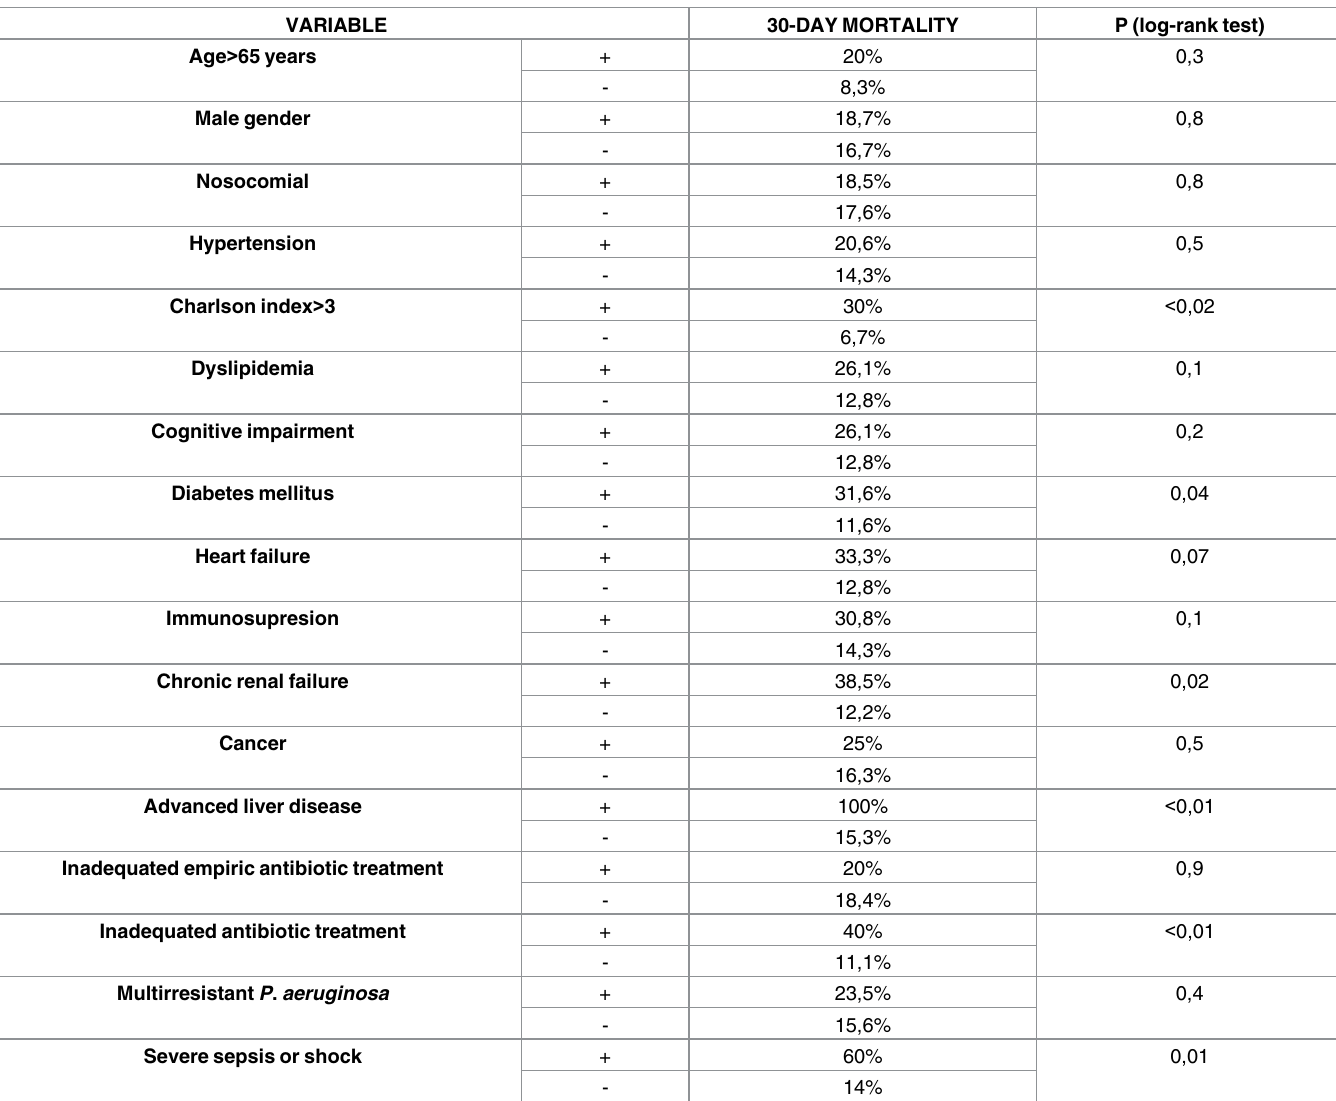
Table 2. Mortality rates at 30